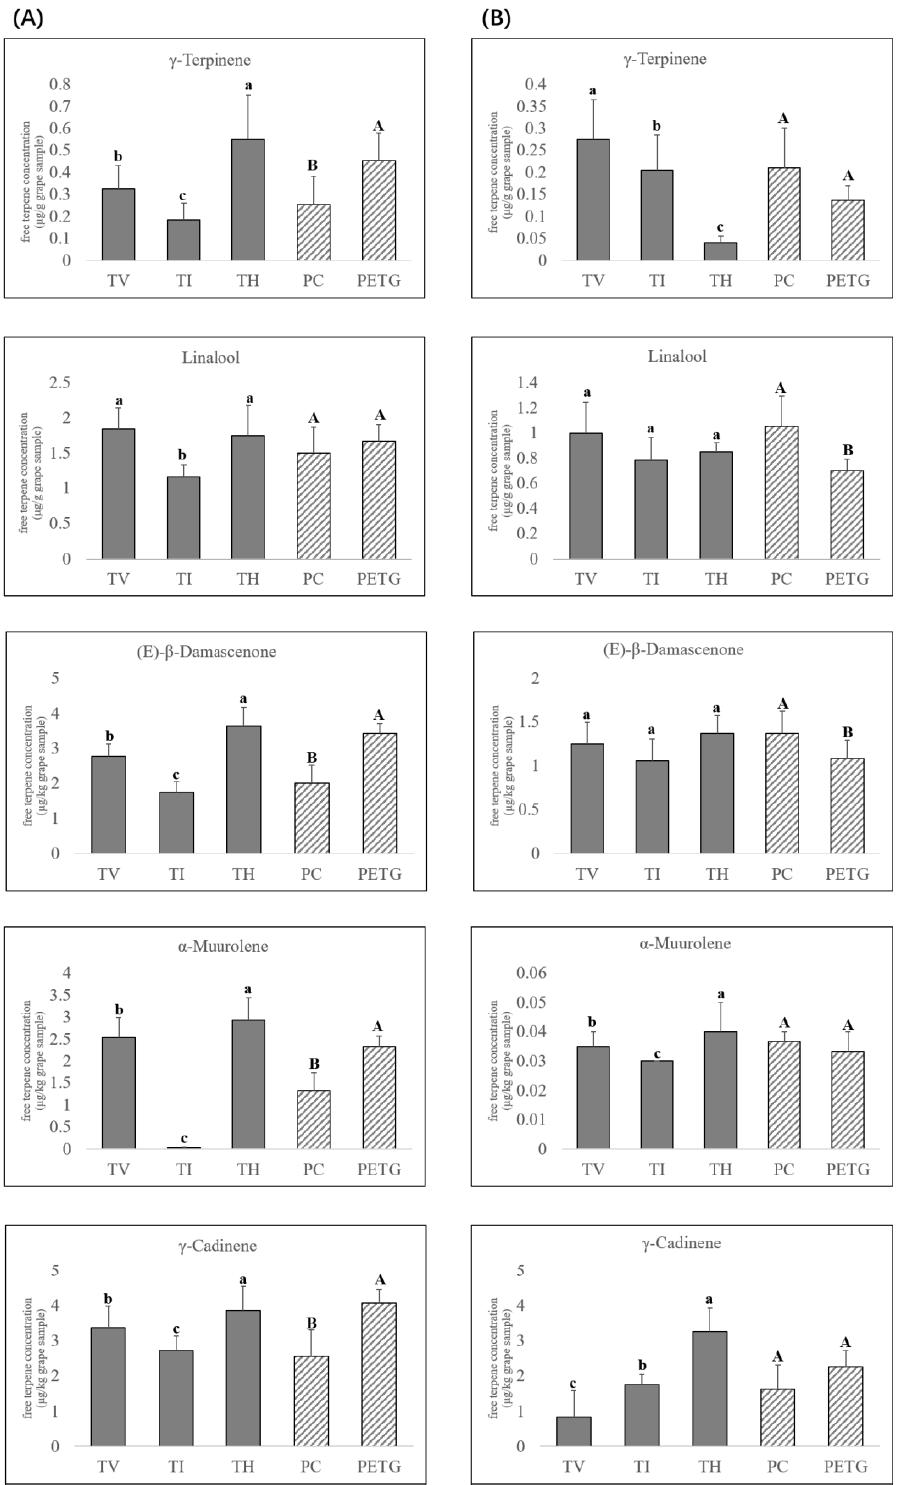
Figure 4. Comparison of key grape terpenes at harvest treated with UV attenuation at different phenological stages in ( A ) vintage 2016 and ( B ) vintage 2017. Two-way ANOVA was conducted to compare grape terpenes between different UV attenuation sheets (A, B were used to illustrate the statistically significant differences at p < 0.05) and applied stages (a, b, c were used to illustrate the statistically significant differences at p < 0.05).